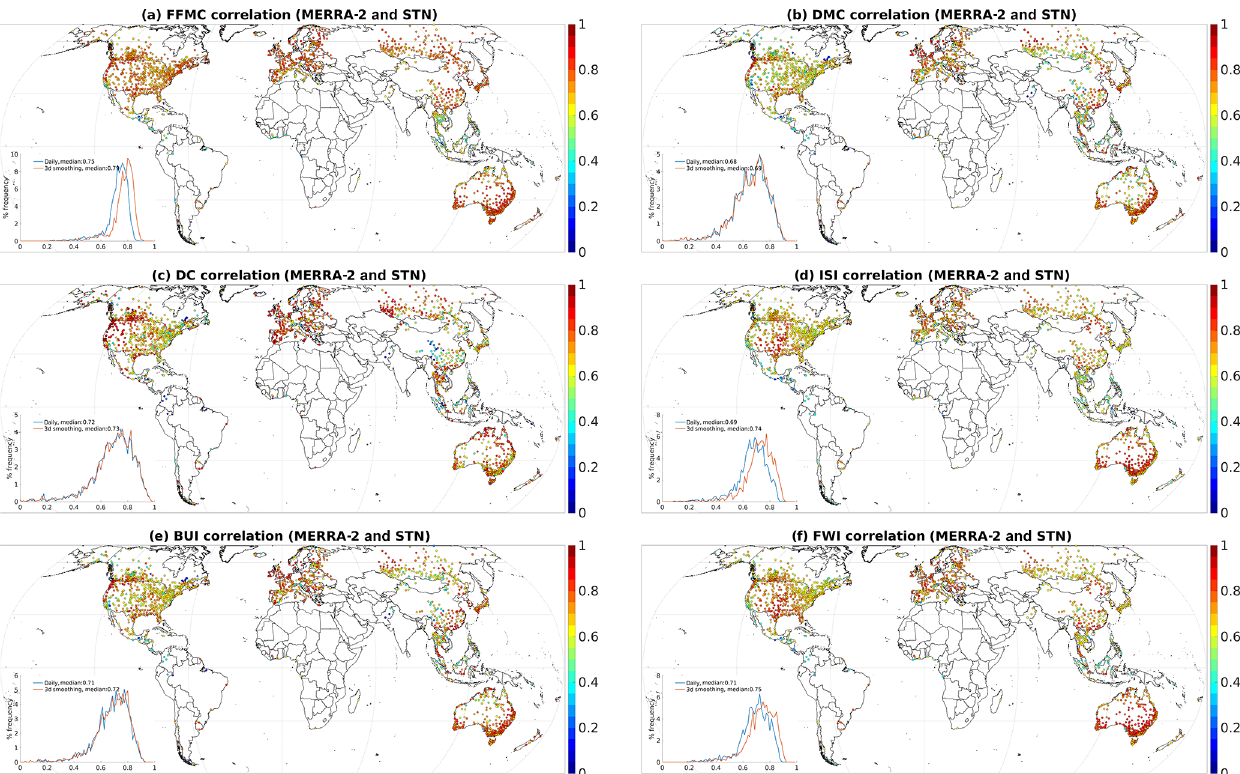
Figure 7. Correlation between daily station and MERRA-2 FWI component values over 2004–2018 during the local 4-month fire season. The inset histograms show the frequency distribution of correlations across all stations for daily, 3, 7 and 30d average FWI components.